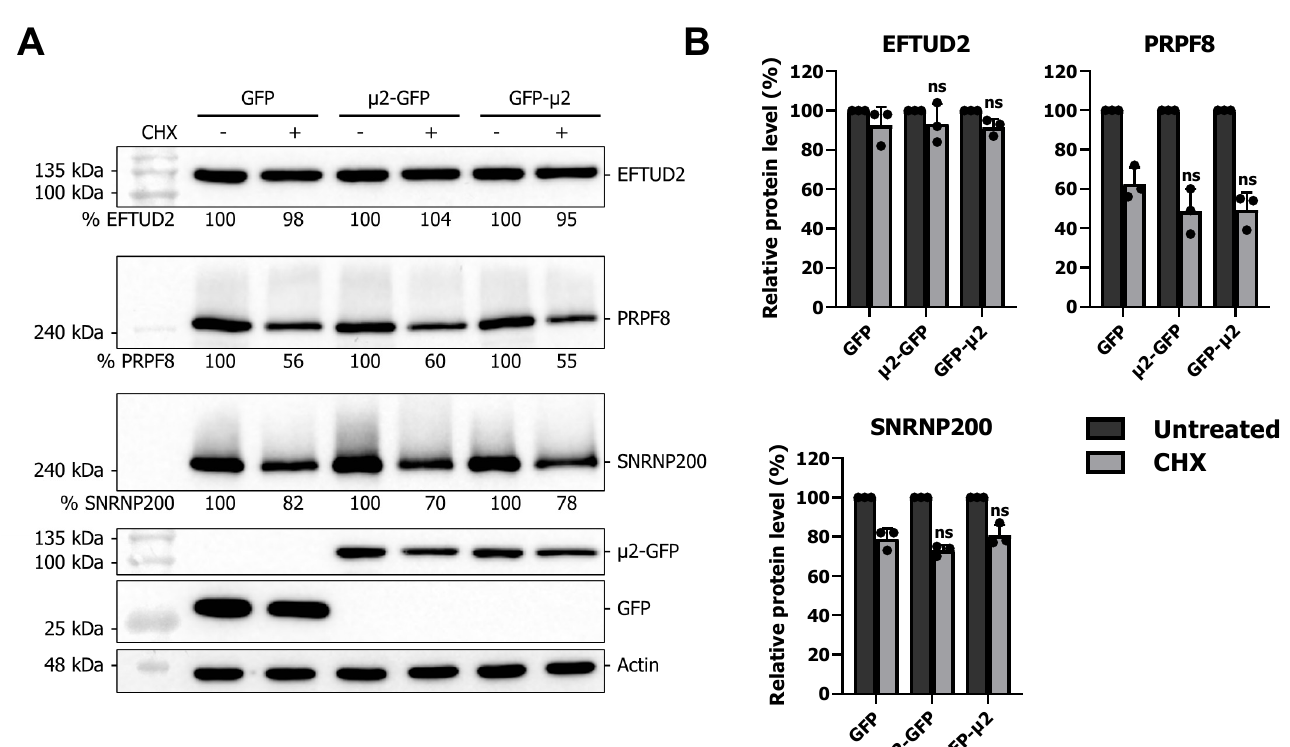
Figure 3. The µ 2 protein does not impact EFTUD2, PRPF8, and SNRNP200 protein degradation: ( A ) WB of EFTUD2, PRPF8, and SNRNP200 in HEK 293T cells transfected for 24 h with GFP, µ 2-GFP, and GFP- µ 2, and then treated with 100 µ g/mL CHX or DMSO for an additional 24 h. Relative quantification is shown and normalized for 100% in the same construction for the control condi- tion; and ( B ) quantification of three independent experiments. n = 3, biological replicates, two-way ANOVA with Dunnett’s multiple comparisons test against the GFP alone condition; only the re- sult of the comparison in the CHX condition is presented (ns, p > 0.05). Results presented are mean ± standard